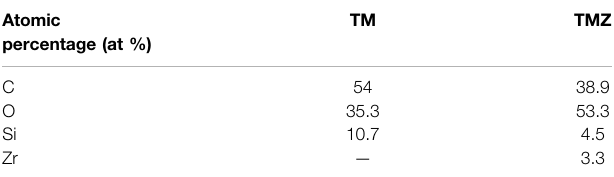
TABLE2| CompositionofTMandTMZcoatingsgiveninatomicpercentage(at%) determined from high energy resolution XPS spectra before immersion in corrosive medium (as-prepared condition).